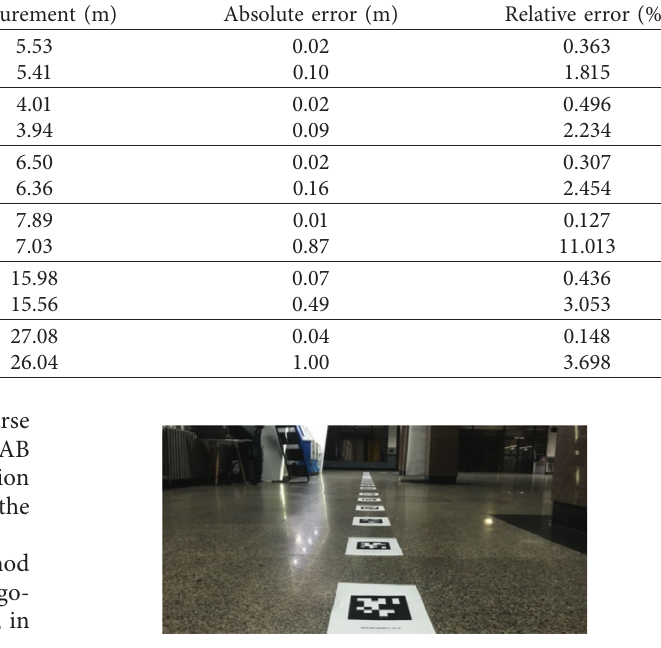
Figure 13: Apriltag on the ground.